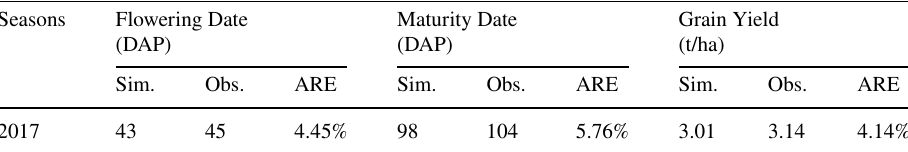
Fig. 3 Comparison of soil water content (SWC) between simulation and observation in the Huaibei Plain study area in Anhui Province, China. Note: DAP = Day after